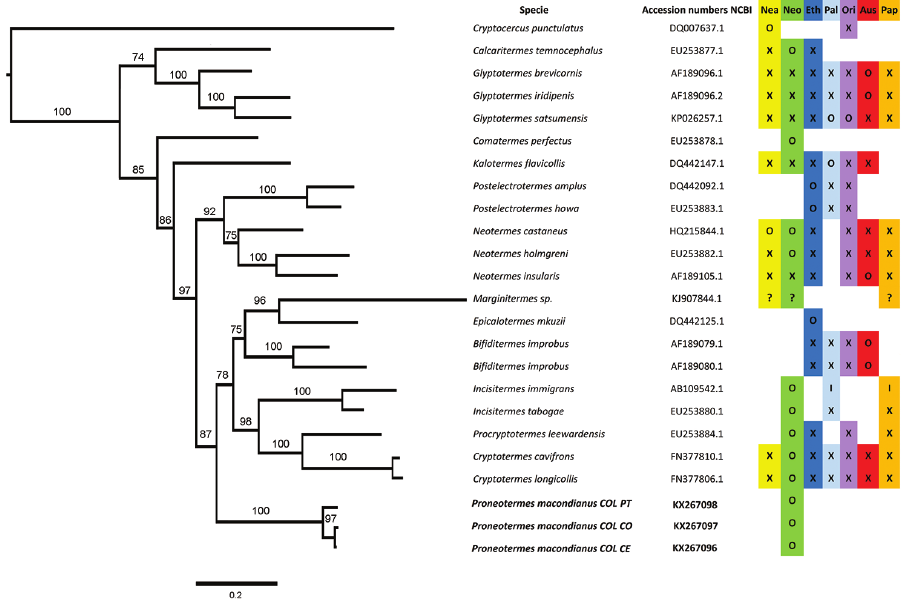
Figure 5. Bayesian inference tree, inferred with MRBAYES from COII sequence data (nodes show pos- terior probability support). Kalotermitidae distribution (X), Species distribution known (O), unknown (?) and established introductions from other regions (I). Neartic = Nea, Neotropic = Neo, Ethiopian = Eth, Paleartic = Pal, Oriental = Ori, Australian = Aus, Papuan = Pap. Distribution based on Krishna et al.